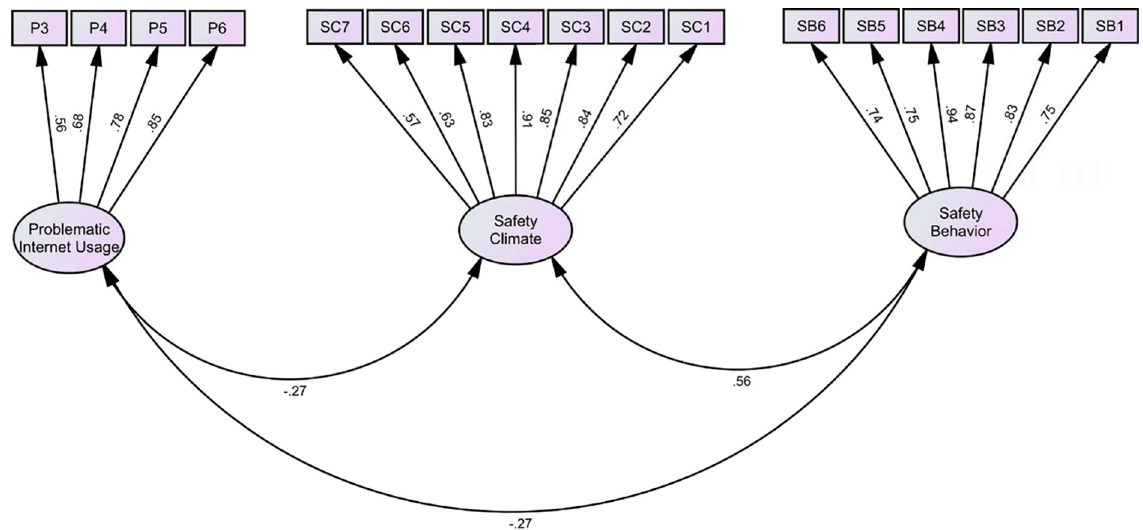
Fig 2. The measurement